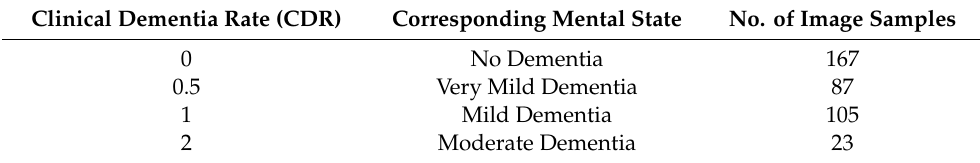
Clinical Dementia Result (CDR) values with the corresponding mental state in the OASIS